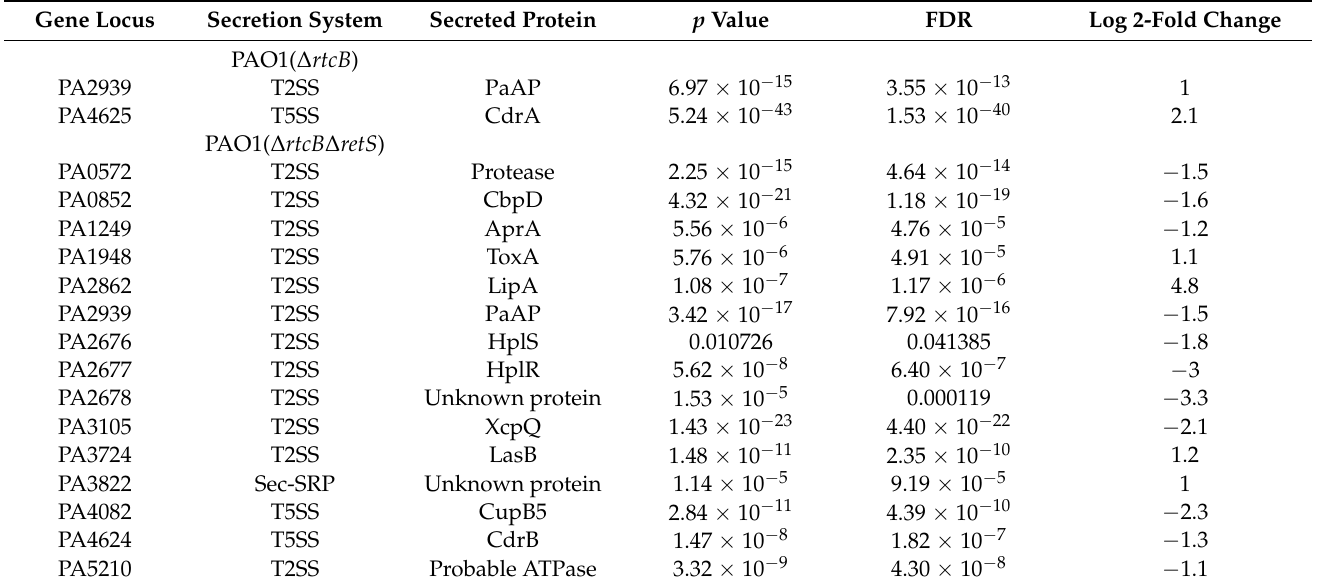
Table 1. Differential expression of secretory proteins of T2SS and T5SS. Gene Locus Secretion